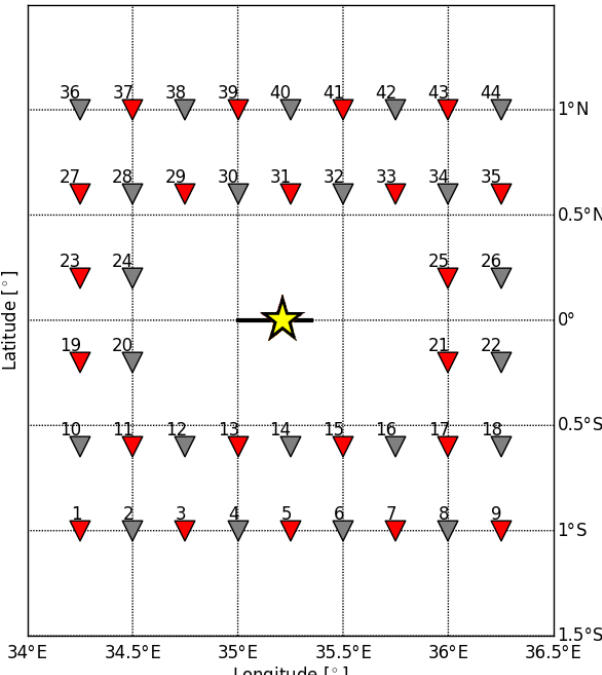
Figure 1. 44 receivers, marked as gray (only used without rotation data) and red triangles (used for all inversions), are set up around the source with a spacing of 0 . 4 ◦ latitude and 0 . 25 ◦ longitude. The fault trace is illustrated as a black line with constant latitude of 0 ◦ . The yellow star marks the epicenter of the